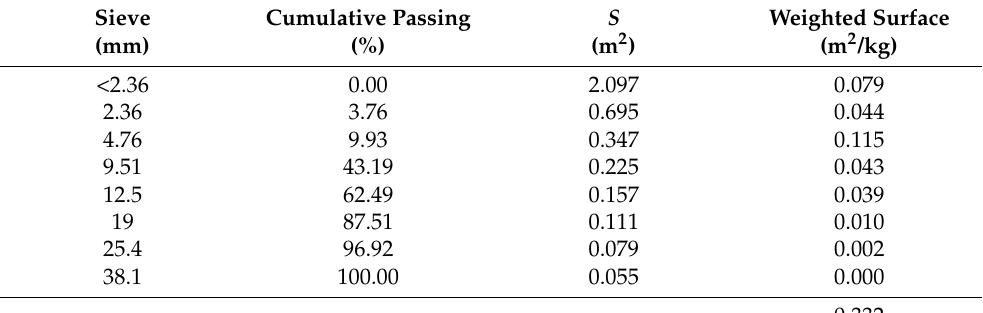
Table 5. Specific surface area of the